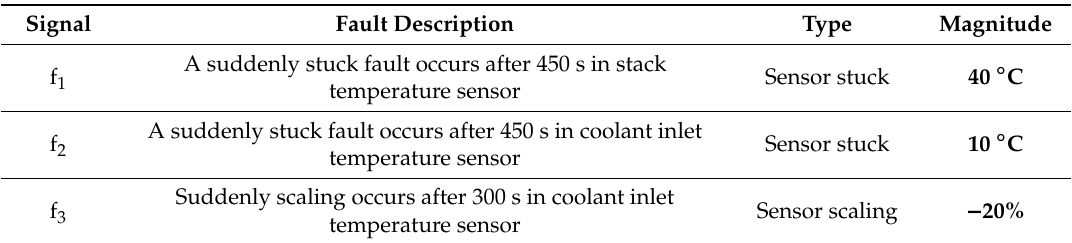
Table 1. Implemented fault